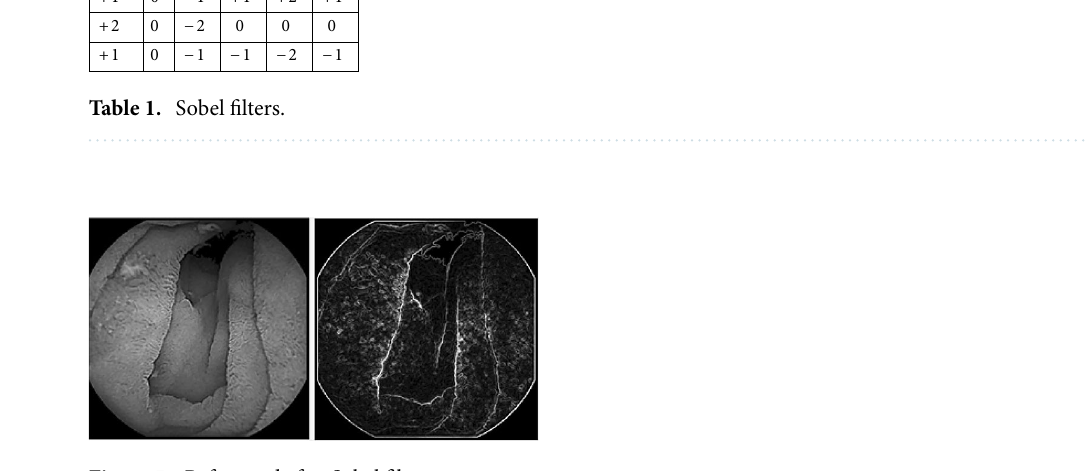
Figure 5. Before and after Sobel filter.